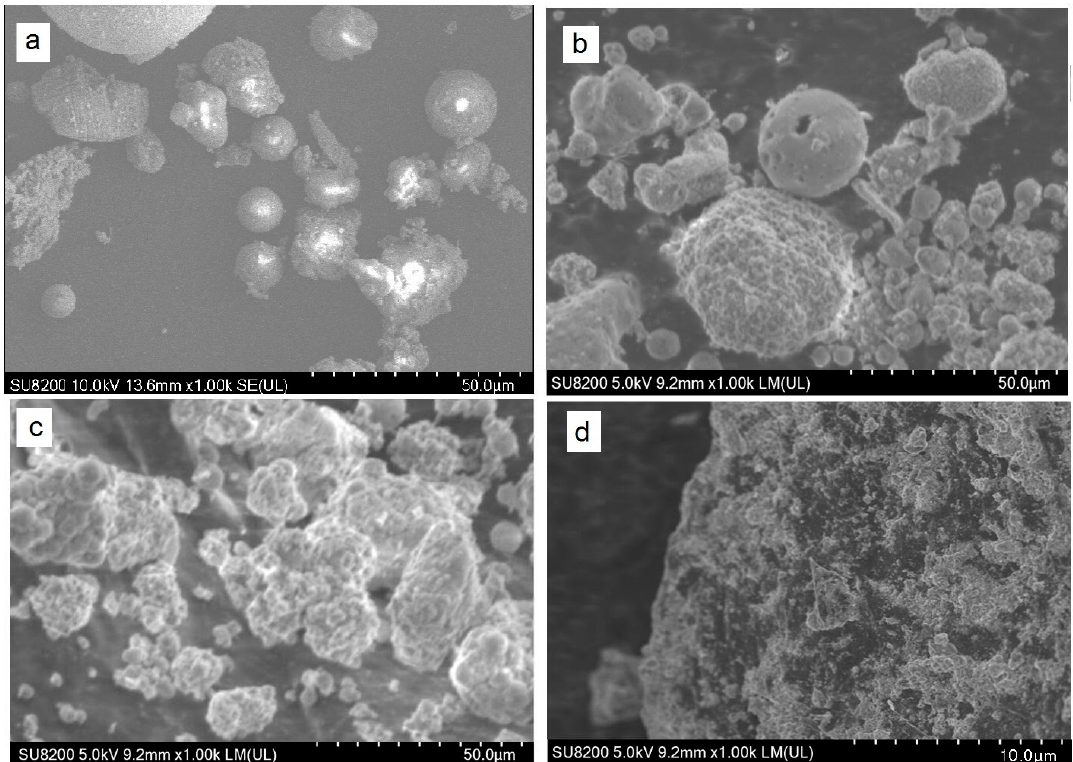
Figure 12. SEM images of samples processed under optimum conditions. ( a ) CFA; ( b ) DCFA; ( c , d ) acid leaching residue (6 mol/L HCl, 120 °C, S/L ratio of 1/20, 4 h).